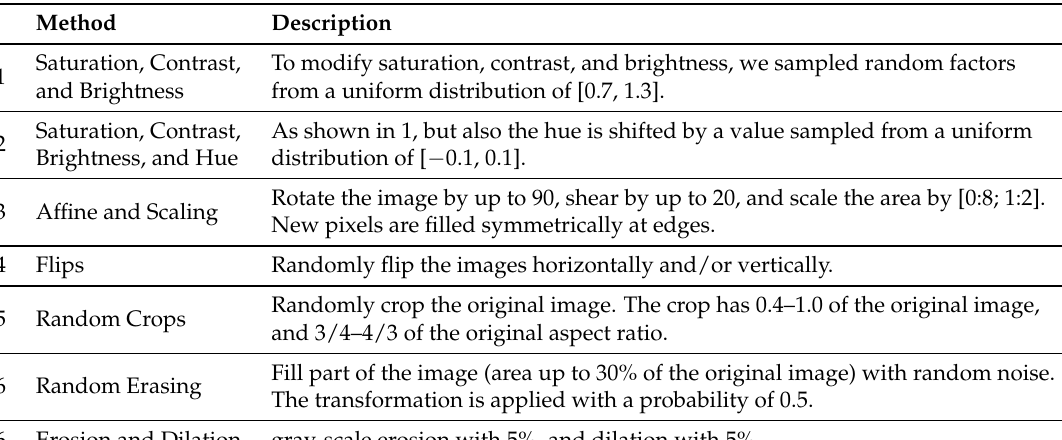
Table 6. Data augmentation